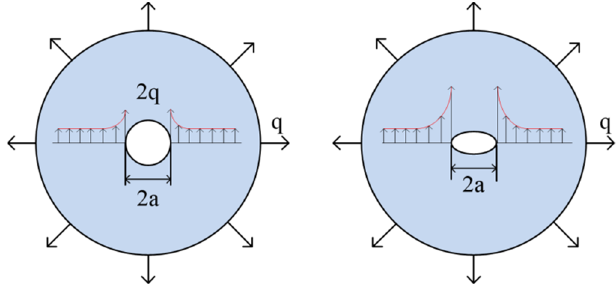
Figure 3. The mechanics model of the film with round and elliptical holes.